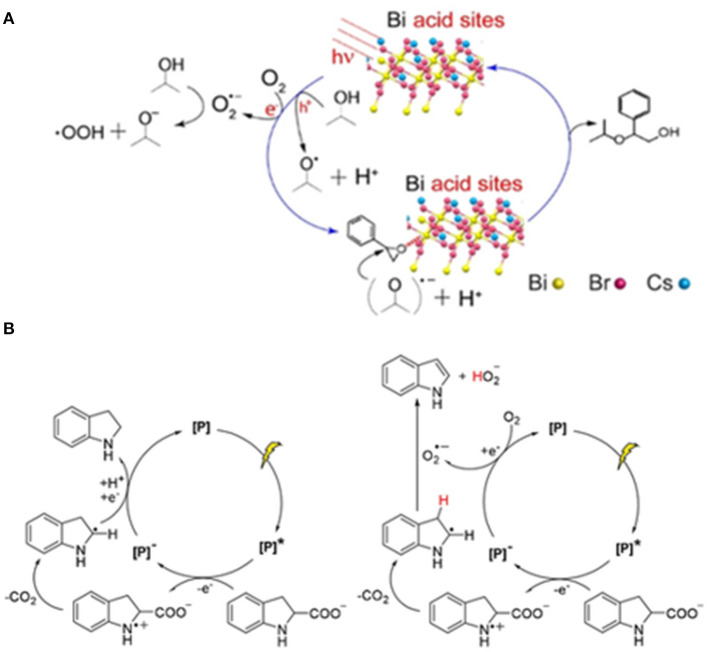
(A) Proposed photocatalytic cycle for epoxide alcoholysis reaction over Cs3Bi2Br9 with proper Lewis acid sites on surface. © © 2019 Wiley-VCH Verlag GmbH & Co. KGaA, Weinheim. (B) Proposed mechanisms for the decarboxylation (left) and dehydrogenation reactions (right). © © 2019 Wiley-VCH Verlag GmbH & Co. KGaA, Weinheim.